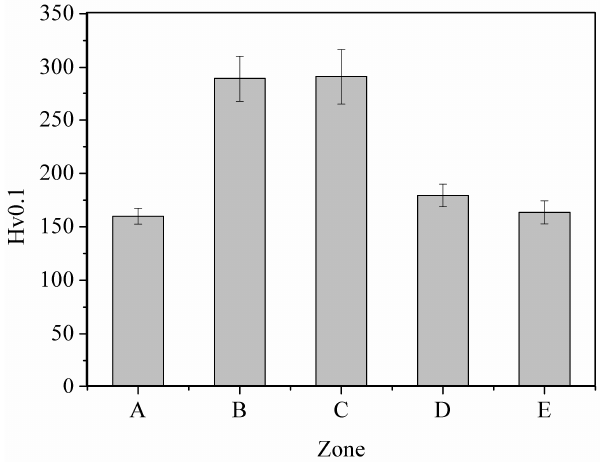
Figure 9. Hardness of the five zones of the weld.